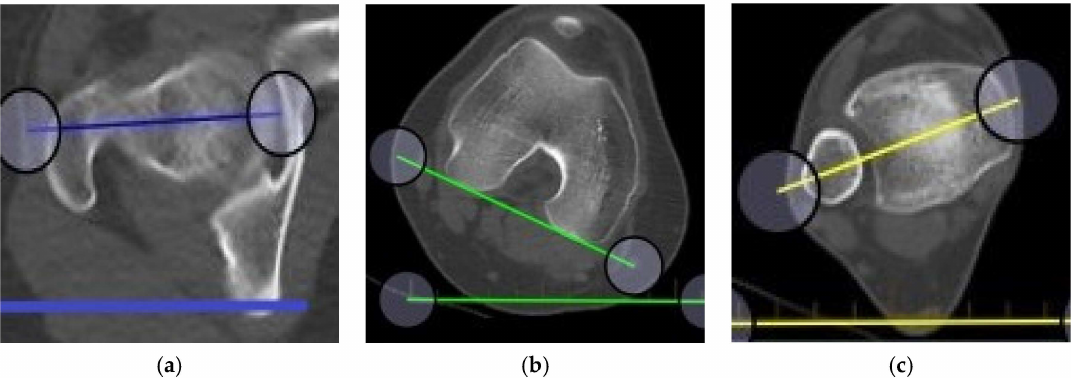
Figure 1. Measurement technique taught in the course: ( a ) right femoral head/neck axis; ( b ) right posterior condylar axis; ( c ) right bimalleolar axis.